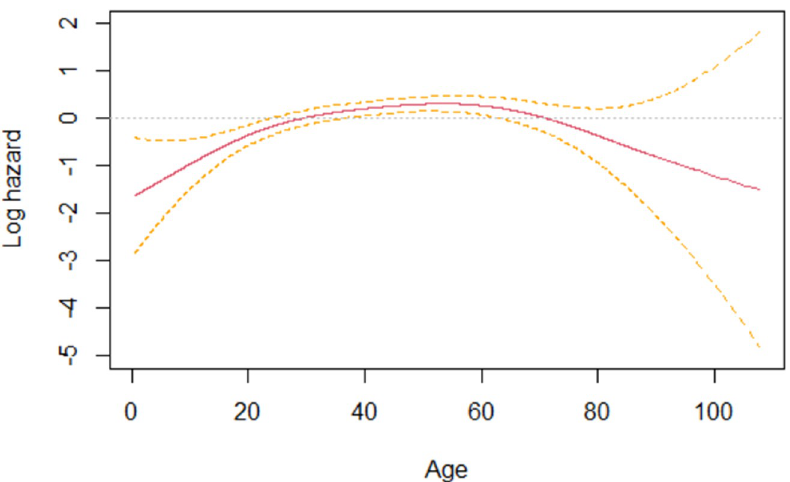
Fig 3. Effect of age on the time interval between the diagnosis of leprosy and cutaneous leishmaniasis in the same individuals according to Cox regression model with P-splines. Solid line represents spline coefficient of each estimated knot while dashed lines are the limits of the 95% confidence intervals. Data from Mato Grosso state, Brazil, 2008–2017.